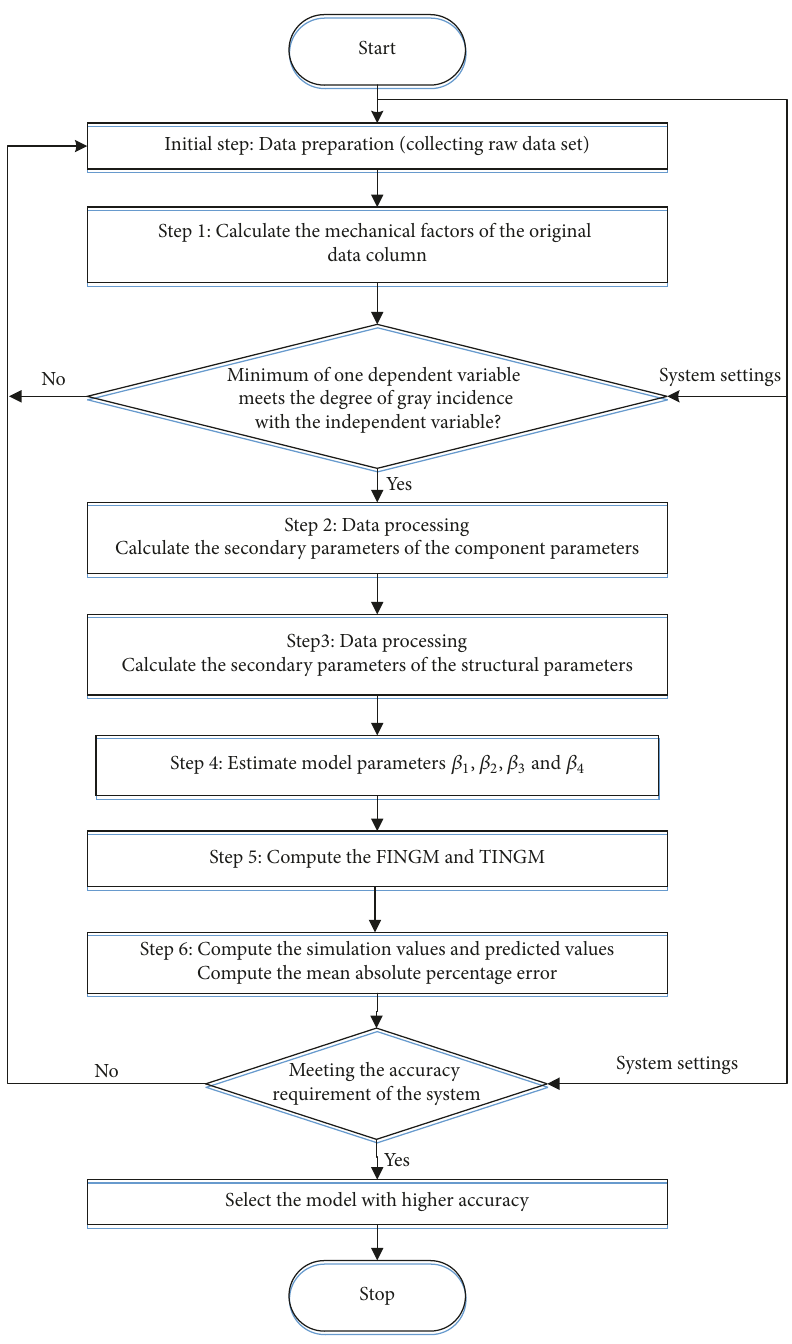
Figure 1: The flowchart of the INDGM.